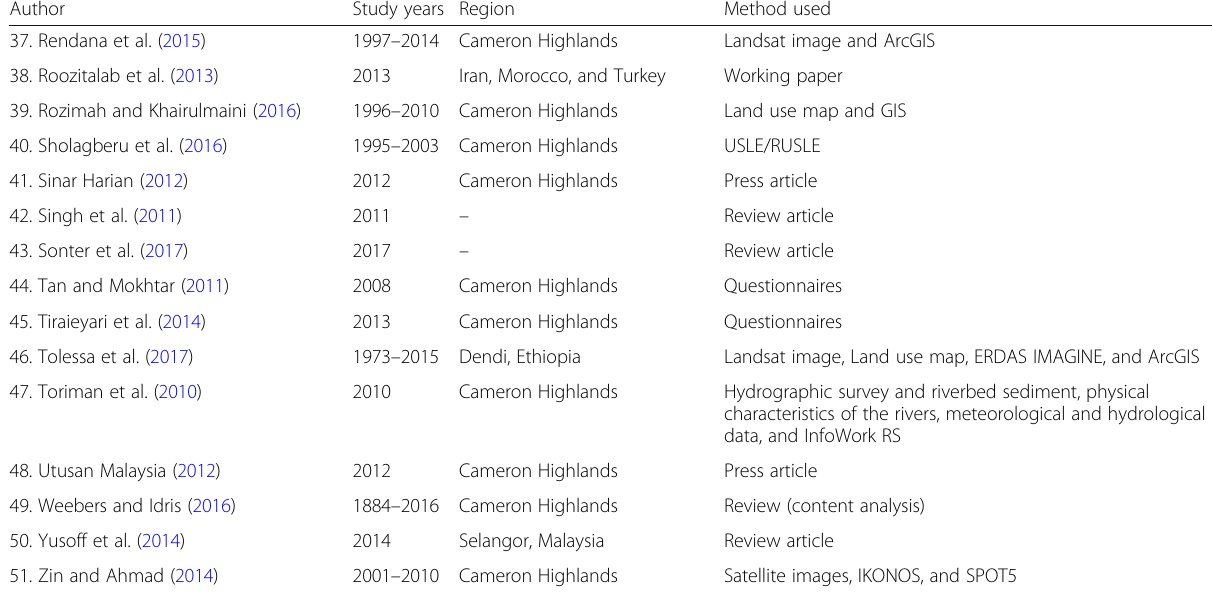
Table 6 Data for land use and land change studies (including agriculture practices, agro-tourism, and policy and management) (Continued) Author